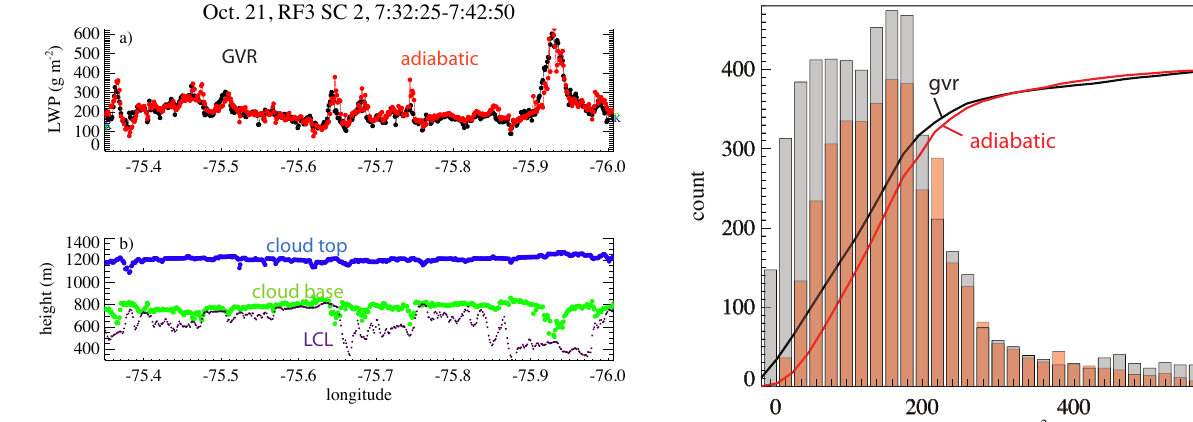
Fig. 8. (a) GVR-retrieved and adiabatically-derived LWP (black and red filled circles respectively) for the RF3 SC2 leg (21 Octo- ber, 02:32:25–02:42:50LT). Retrieved and adiabatic LWP means (standard deviations) are 207 (76) and 211 (69)gm − 2 respectively. Pre-descent and post-ascent LWP values derived from the FSSP and King probes are indicated by a small green “F” and blue “K” at beginning and end of the time series. (b) Corresponding lidar- inferred cloud base (green), the lifting condensation level (purple), and radar-derived cloud top (blue).